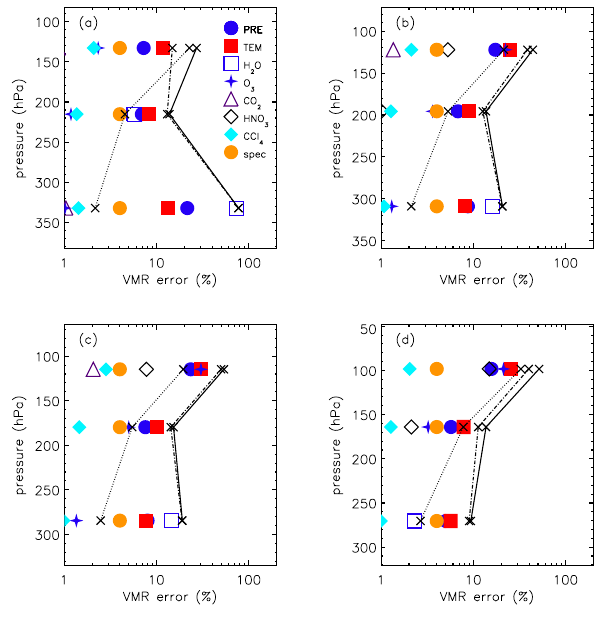
Fig. 2. Error budget for PAN vmr retrievals. The data have been split into regimes, (a) 20 ◦ S–20 ◦ N – tropical, (b) 20 ◦ –65 ◦ – mid- latitudes, (c) 65 ◦ –90 ◦ in the summer hemisphere – polar summer, (d) 65 ◦ –90 ◦ in the winter hemisphere - polar winter. The solid black line represents the total error on a single retrieval. The random (dot- ted) and systematic (dashed) component of the error are also